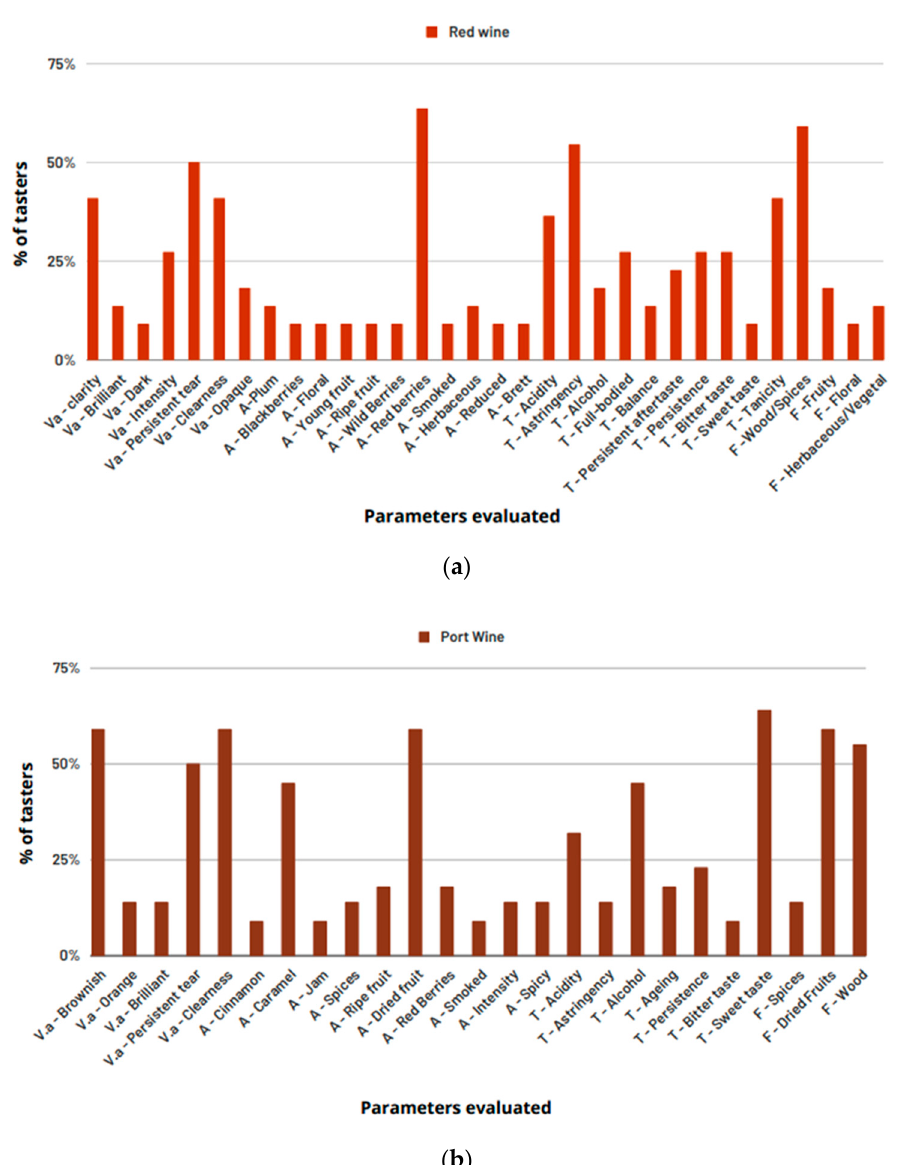
Figure 2. Percentage (%) of P2 tasters by parameters evaluated for red wine ( a ) and port wine ( b ) (Va—visual aspect; A—aroma; T—taste/texture; F—flavor).